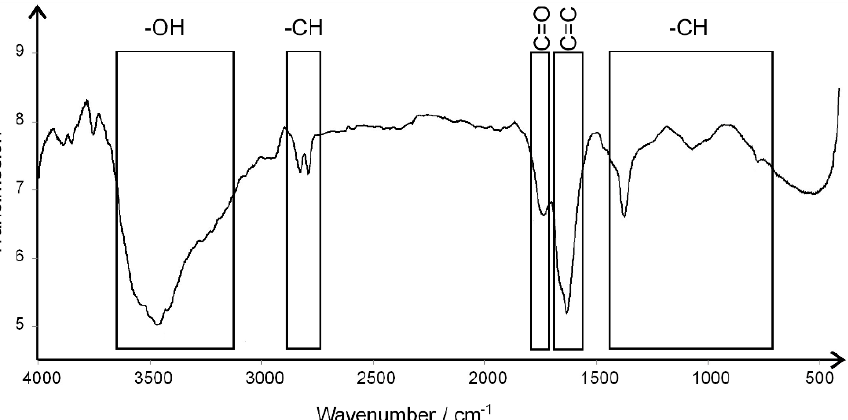
Figure 2. FTIR spectrum of silver nanoparticle and graphene oxide complex (AgNP-GO) registered in the middle region (4000 – 400 cm −1